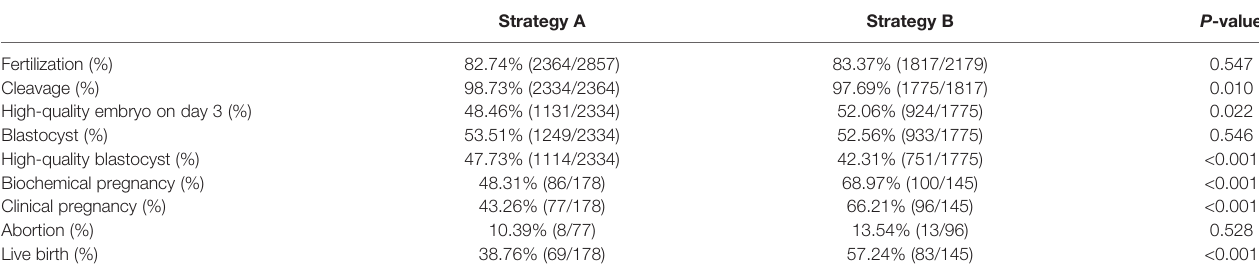
TABLE 2 | Embryo development and clinical outcomes.